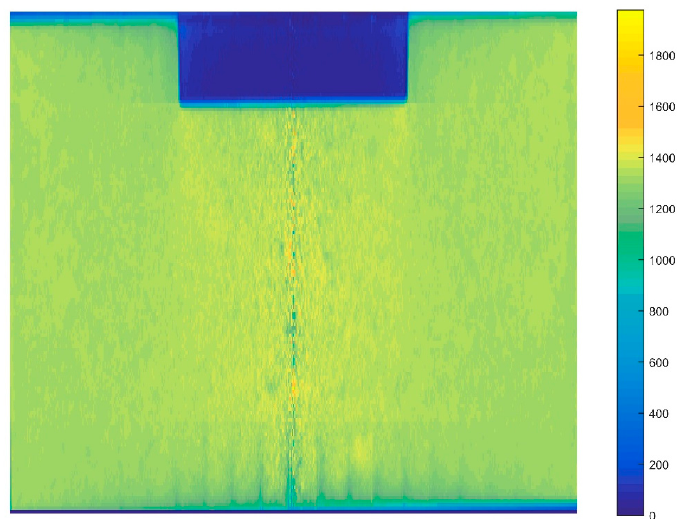
Figure 14. Mean distribution of the density along the radial axis for the sample with the stub hole.